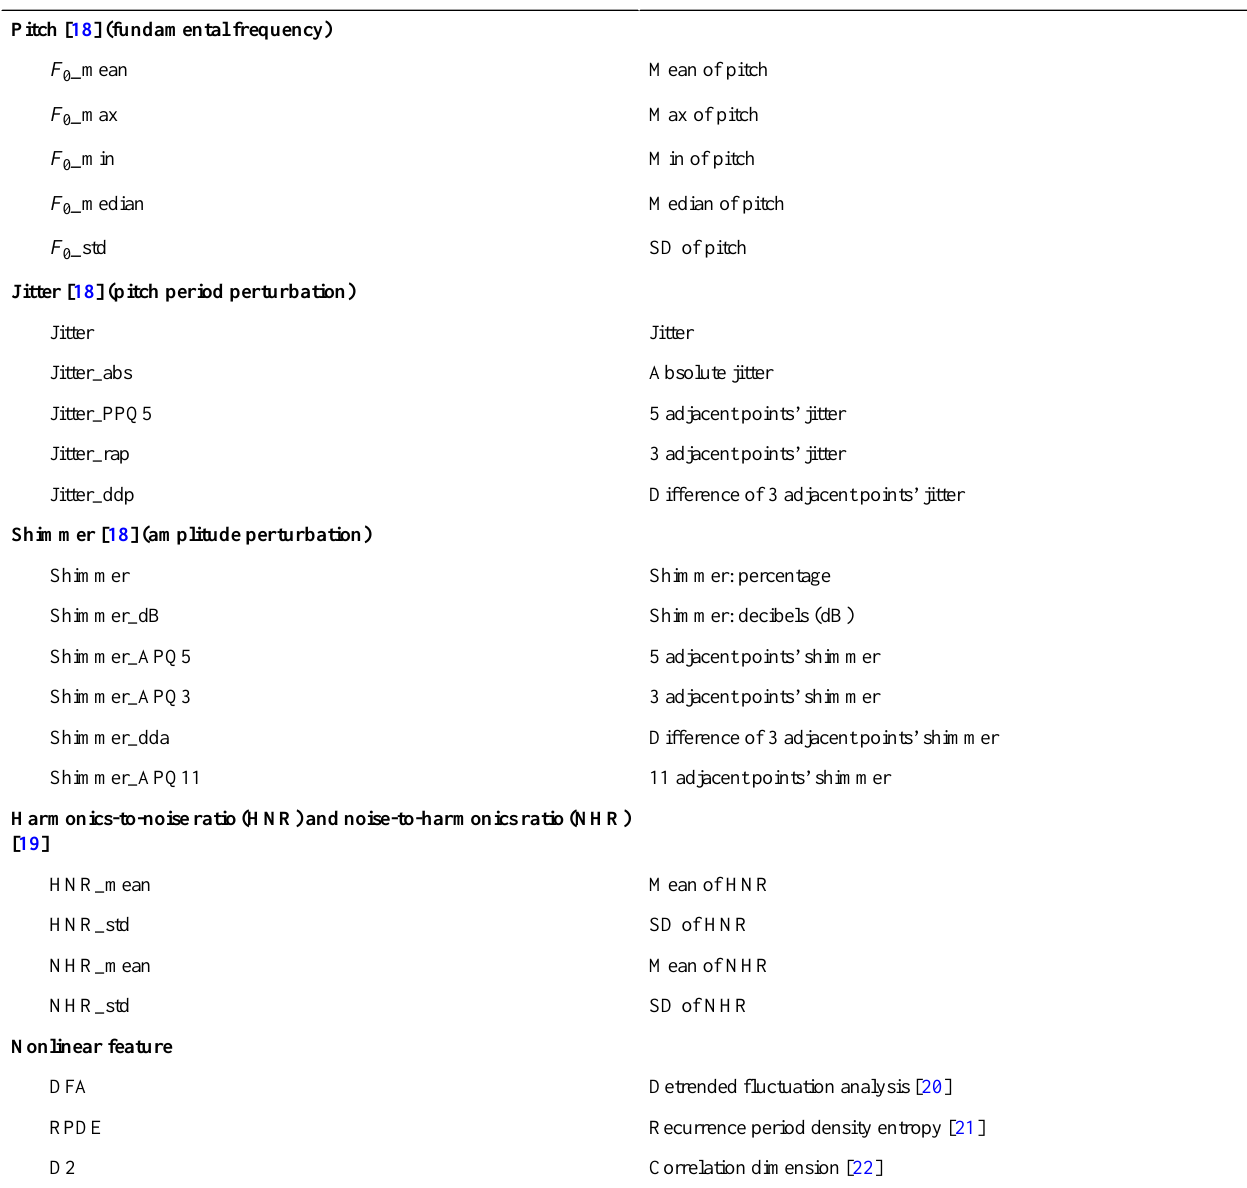
Table 2. Dysphonia features. DescriptionClassification and dysphonia